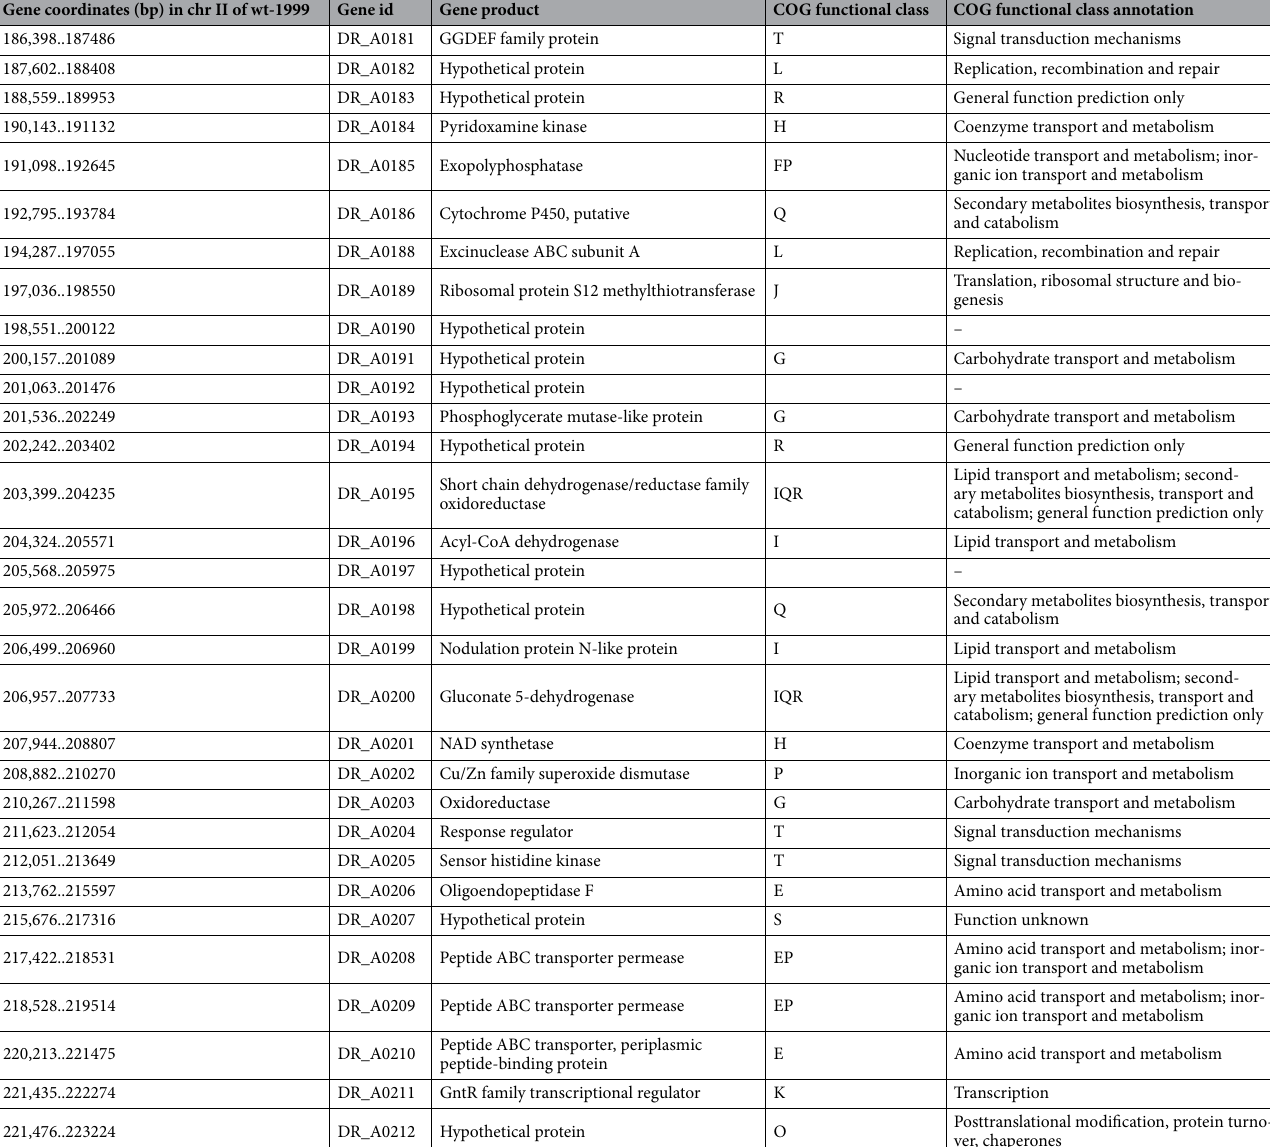
Table 3. Annotations of genes within the region of chromosome II deleted in all the D. radiodurans recA isolates. Annotations have been obtained from the wt-1999 sequence on the basis of sequence